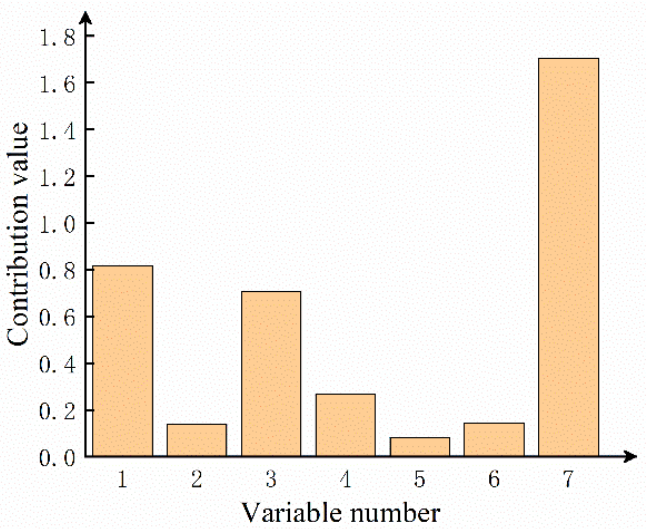
Figure 21. Nonlinear contribution plot of sample 2.